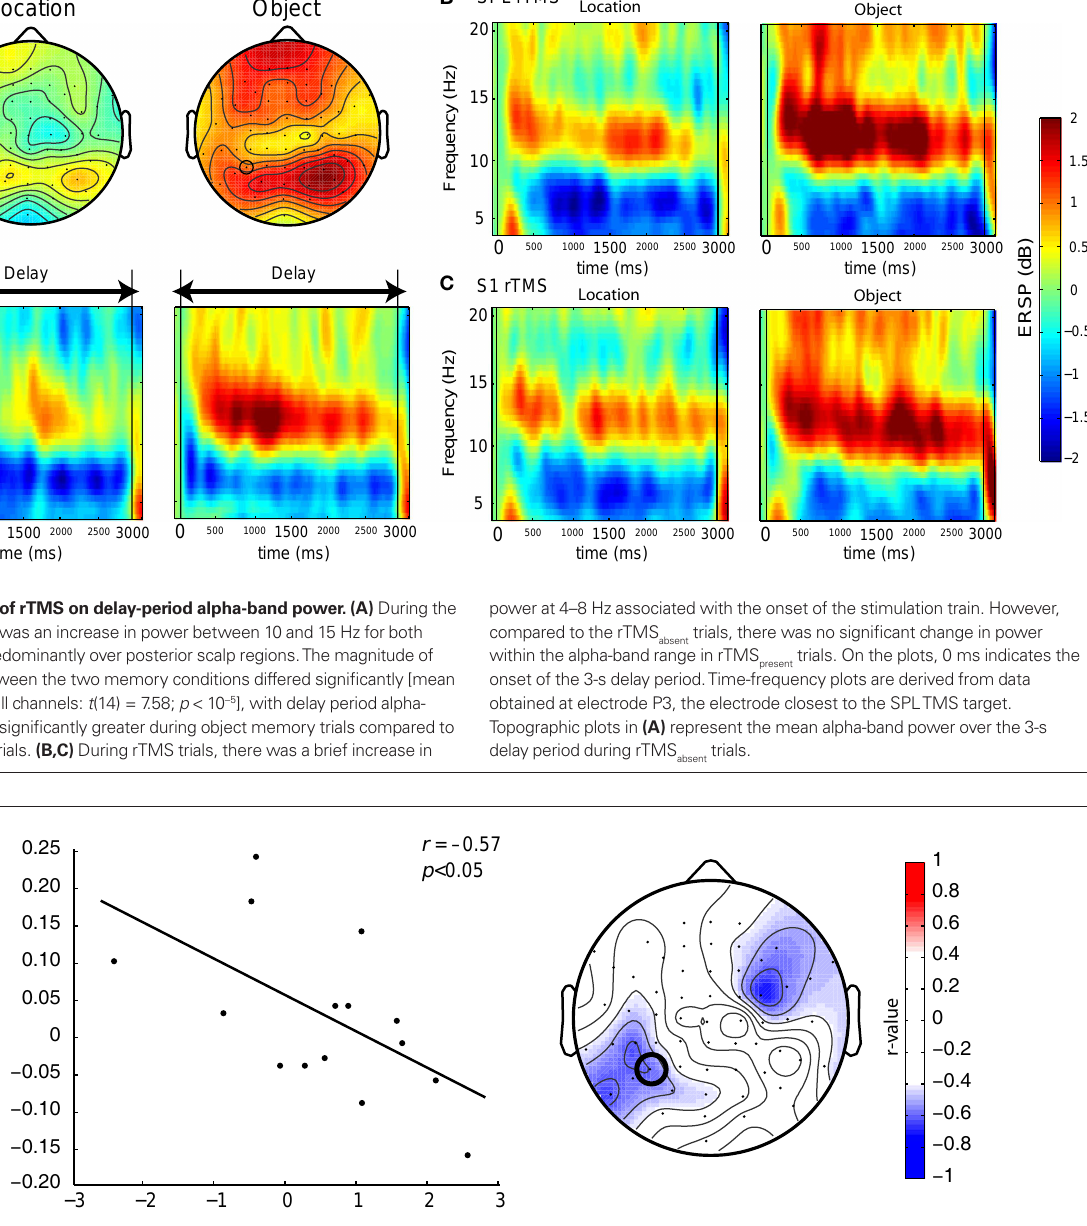
FIGURE 4 | Negative correlation between SPL rTMS-induced change in location of stimulation, and another right, frontal cluster of channels. For S1 alpha-band power and change in accuracy during location working rTMS and for both object memory conditions, there was a trend toward a memory trials. Change in alpha-band power (averaged over 8.5–14 Hz) was positive relationship between rTMS-induced change in alpha-band power and calculated for each subject as the mean difference in alpha-band power change in accuracy (this trend became signifi cant during the second half of the between rTMS and rTMS trials over the entire 3-s delay period. This delay period). Data shown is from the electrode immediately below the TMS absent present correlation was observed over a left, posterior cluster of channels, near the coil (electrode P3, correlations varied, but in general were located in posterior parietal observed a positive correlation between the effect of rTMS on accu- and bilateral occipital cortices (see Figure 5 for details). For all task racy and its effect on alpha-band power ( Figures 5B–D ). These conditions, the correlations were stronger during the second half correlations signifi cantly differed from that of SPL rTMS during of the delay period. location memory ( p -values < 10 − 4 ). The source estimates of these